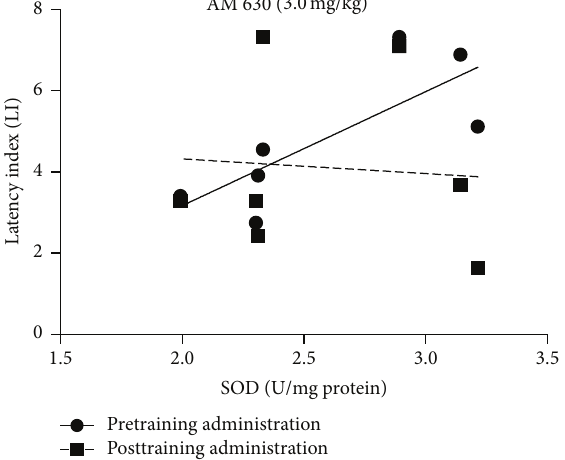
Figure 5: Correlations between the change in LI values in the PA test for the acquisition or consolidation of long-term memory and the concentration of TAC in the mice brain induced by the acute pretraining or posttraining injection of CB1 receptor antagonist AM 251 at the dose of 3.0 mg/kg.